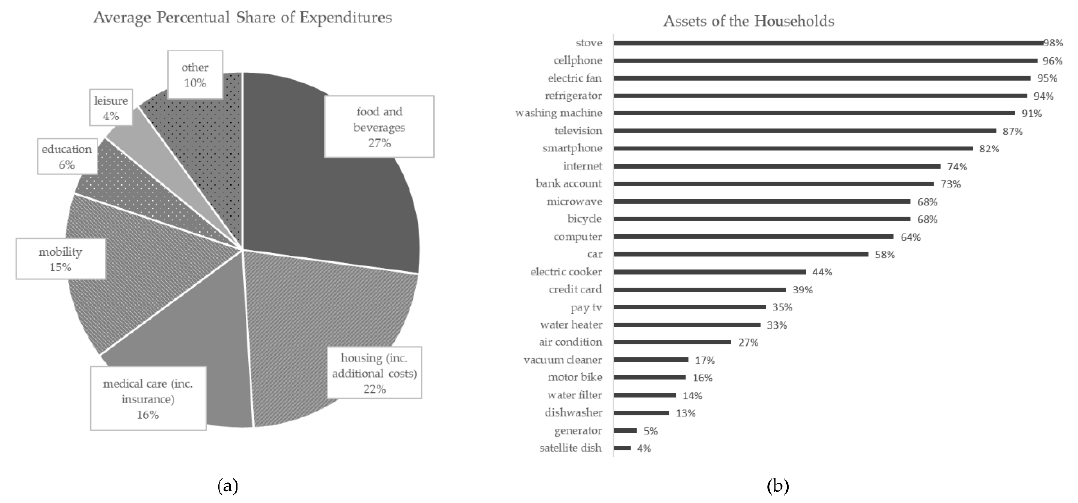
Figure 7. Percentage share of household expenditures ( a ) and household assets ( b ) in Belmopan ( n = 395 interviews).